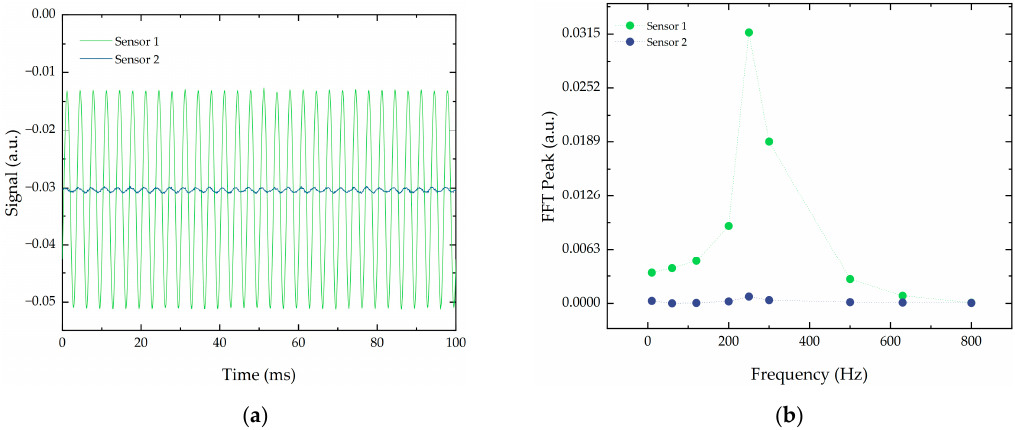
Figure 4. Output signal of the two sensors for a vertical vibration with an acceleration of 10 m/s 2 : ( a ) temporal signal and ( b ) corresponding FFT signal.